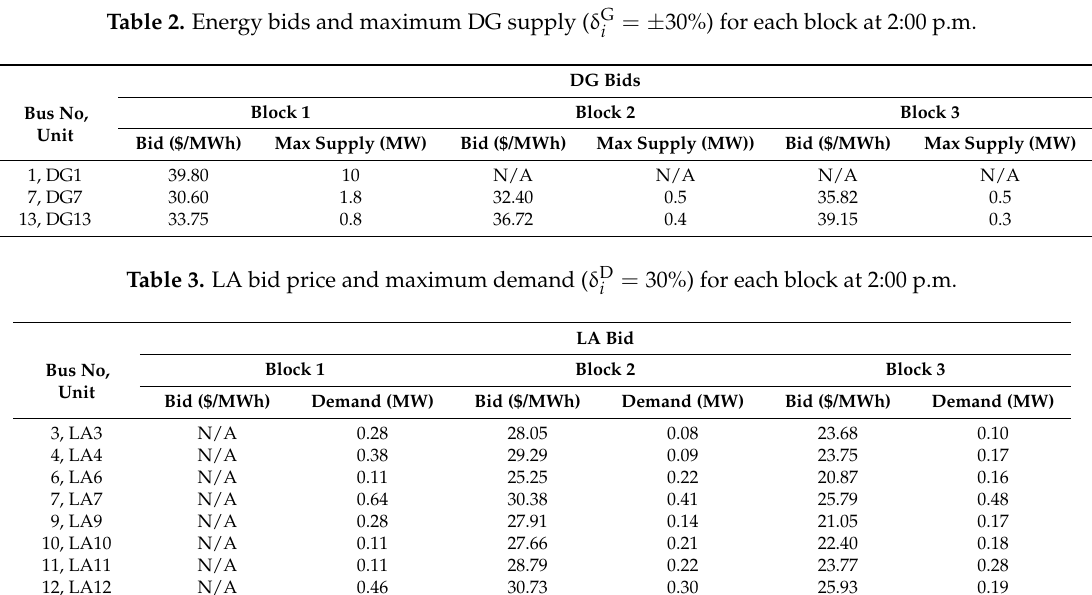
Table 2. Energy bids and maximum DG supply ( δ G